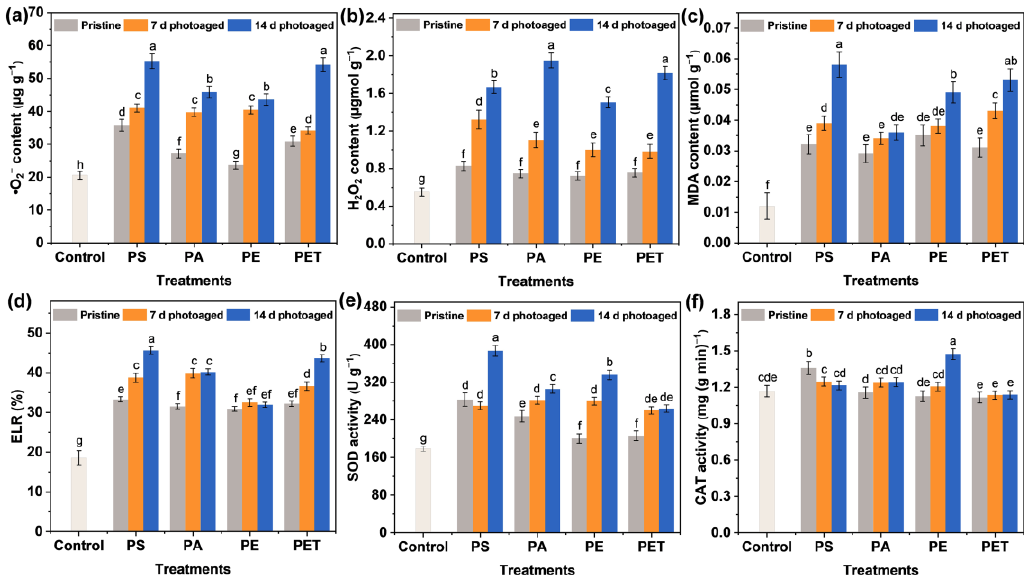
Figure 5. The concentration of ( a ) •O 2 − and ( b ) hydrogen peroxide (H 2 O 2 ), ( c ) malondialdehyde (MDA) content, ( d ) electrolyte leakage rate (ELR), and the activities of ( e ) superoxide dismutase (SOD) and ( f ) catalase (CAT) in roots after 7 d of exposure to 100 mg L −1 different MP suspensions. The number of samples for the repeated experiments is n = 3. Data are expressed as the mean ± SD. Different lowercase letters indicate significant differences between experimental groups ( p < 0.05).